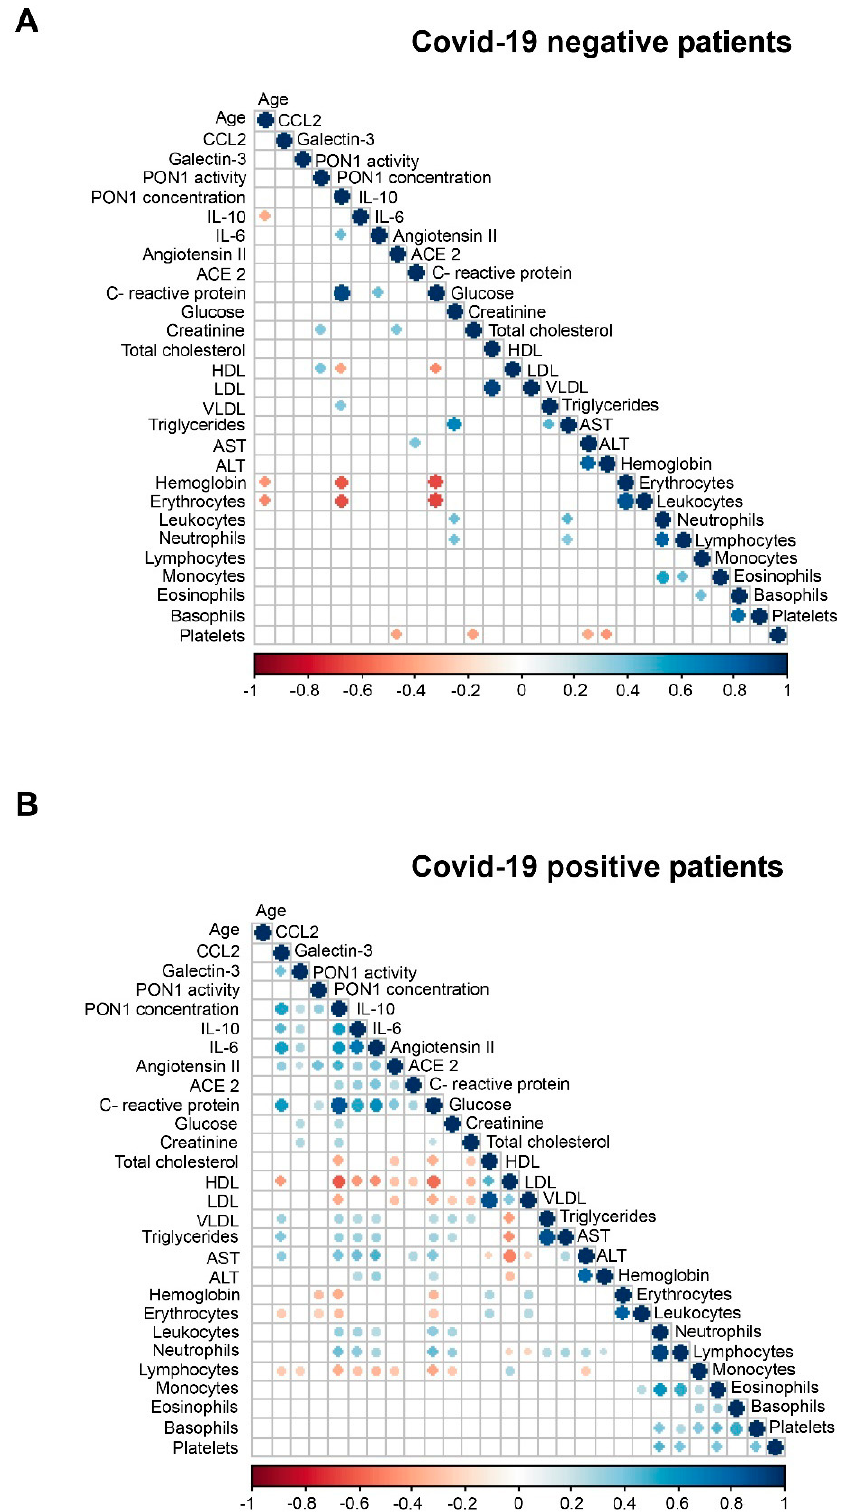
Figure 2. Spearman correlation matrices of analytical variables in COVID-19 negative ( A ) and COVID-19 positive ( B ) patients. The magnitude and direction of the correlations are shown by circle size (larger is stronger) and with colors (positive correlation: blue; negative correlation: red), respectively.